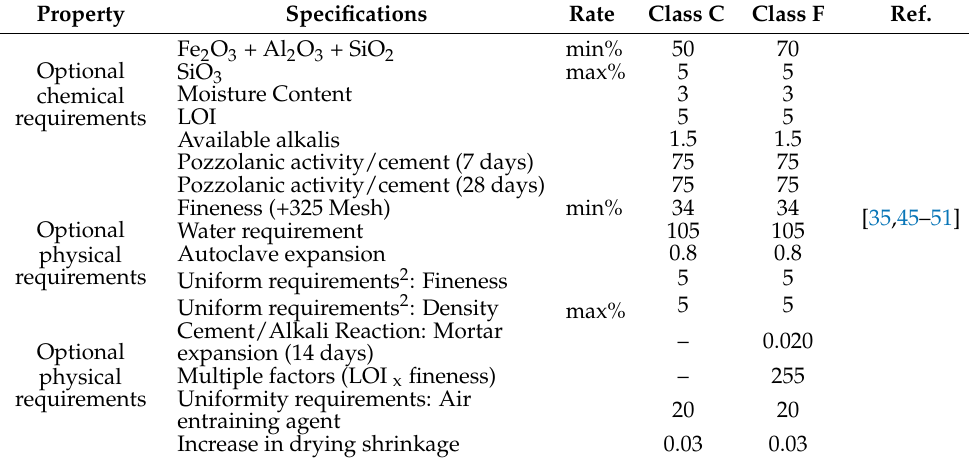
Table 1. Specifications for class F and class C fly ash (FA).